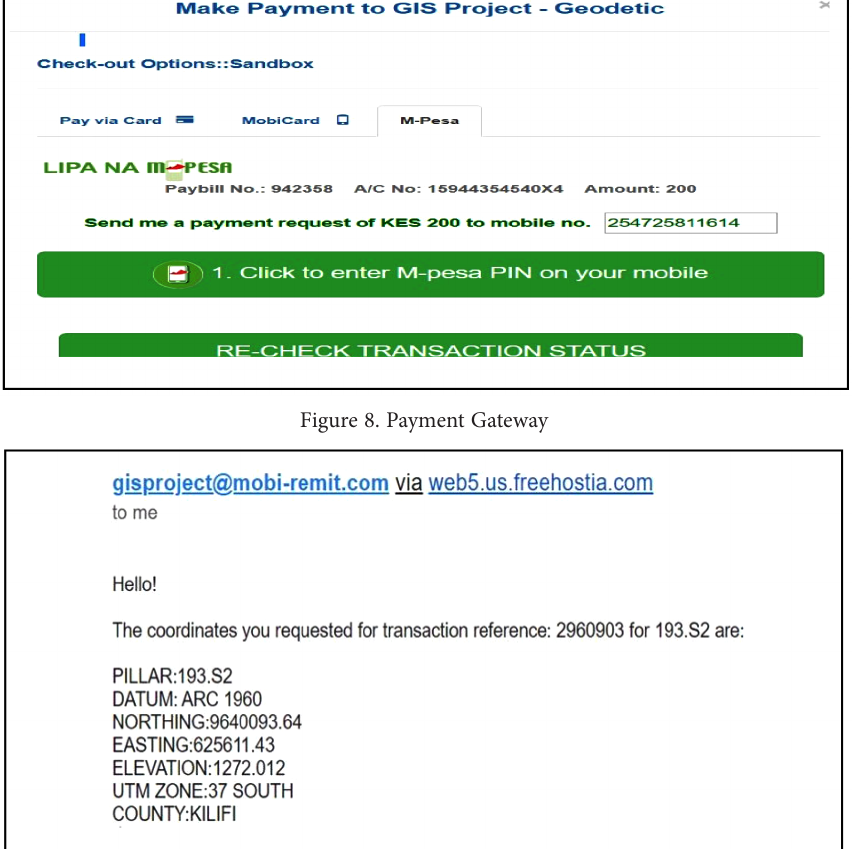
Figure 8. Payment Gateway